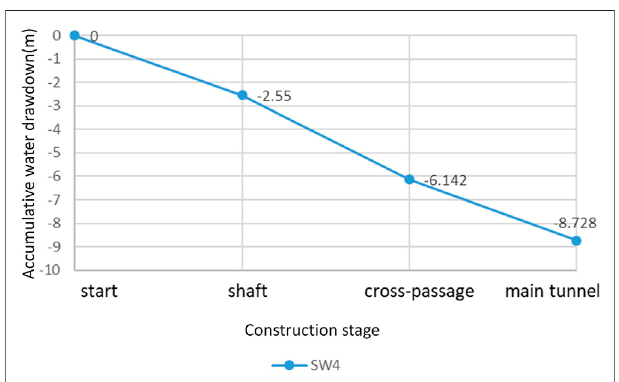
FIGURE 8 | Groundwater drawdown data around the shaft (up to June 30,